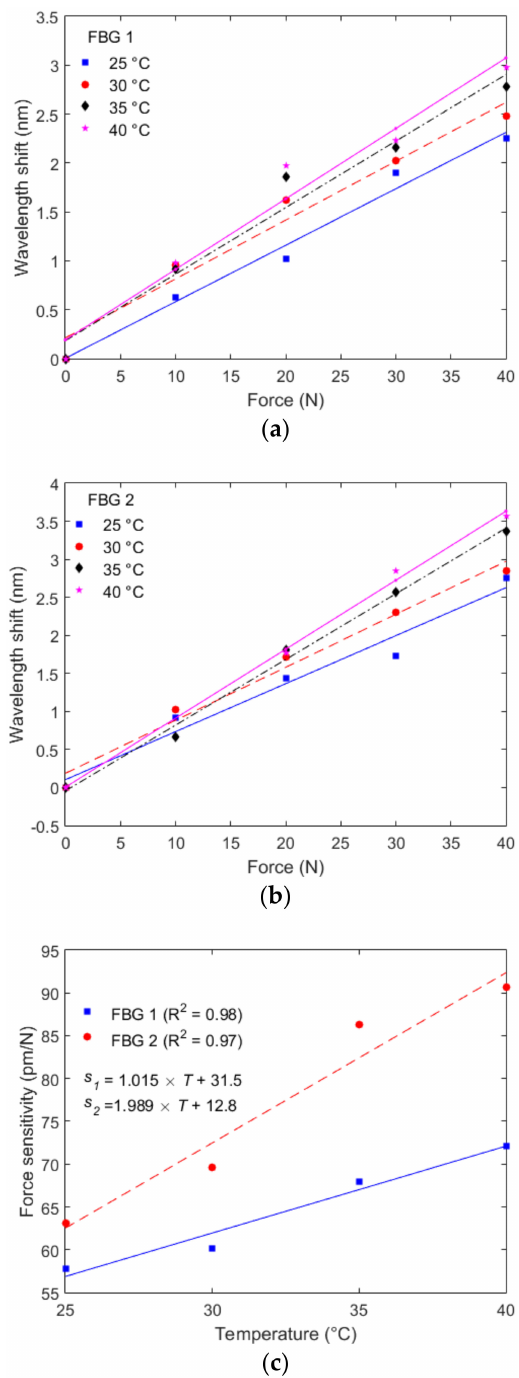
Figure 7. ( a ) Force characterization at different temperatures for FBG 1; ( b ) Force characterization at different temperatures for FBG 2 and ( c ) Force sensitivity as a function of the temperature for FBGs 1 and